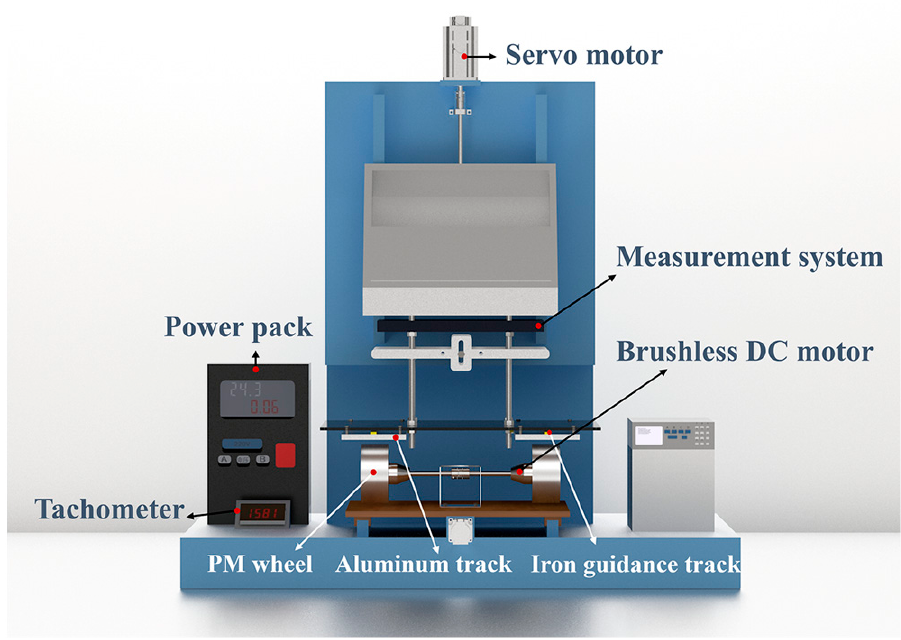
Figure 18. Schematic diagram of the annular PM EDS experimental prototype.